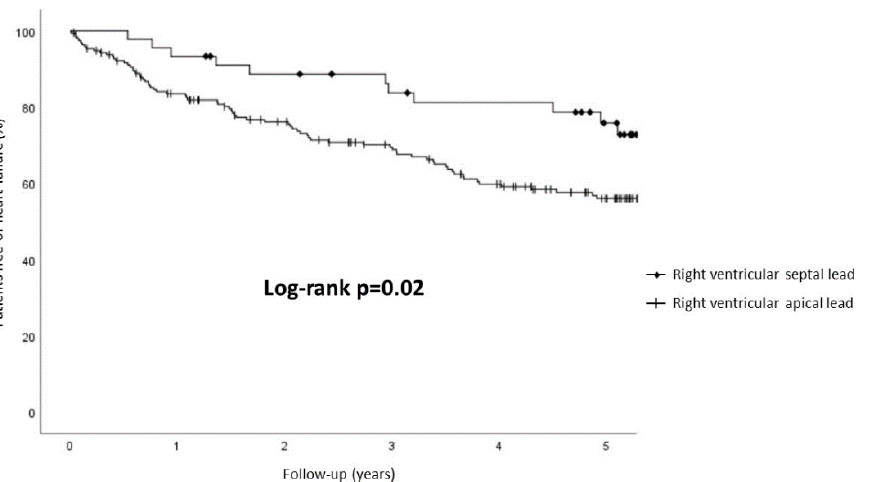
Figure 1. Cumulative heart failure and all-cause mortality event rate at 1, 3, and 5 years of follow- up.